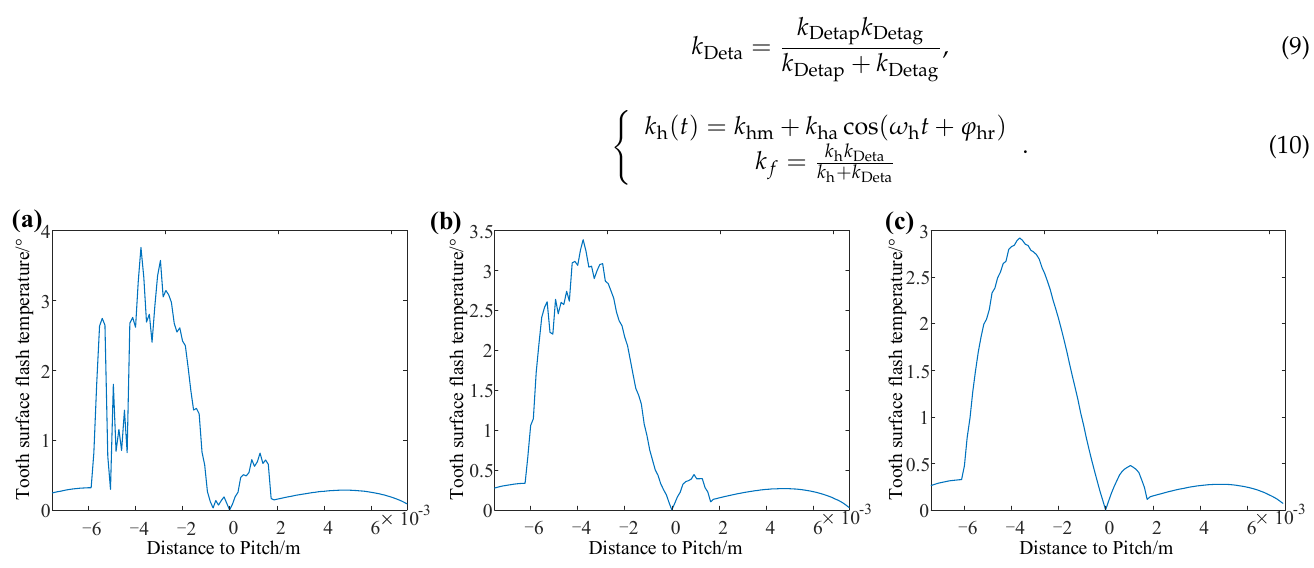
Figure 6. Tooth surface flash temperature with different fractal dimension D . ( a ) D = 1.43. ( b ) D = 1.5. ( c ) D = 1.6.